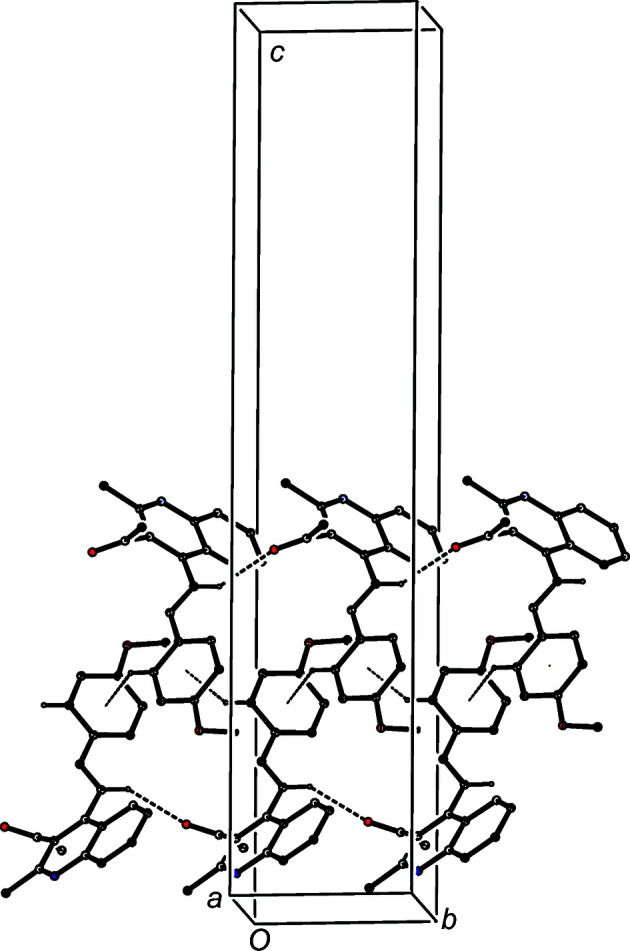
Part of the crystal structure of com­pound (I), showing the formation of a chain of rings along [010] built from C—H⋯O and C—H⋯π(arene) hydrogen bonds, drawn as dashed lines. For the sake of clarity, H atoms not involved in the motifs shown have been omitted.